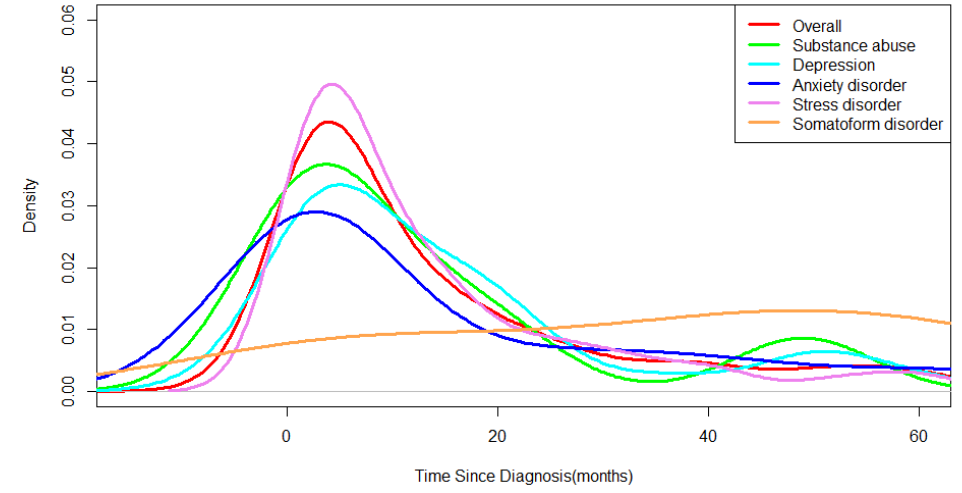
Figure 3. The frequency density by metal disorder in breast cancer